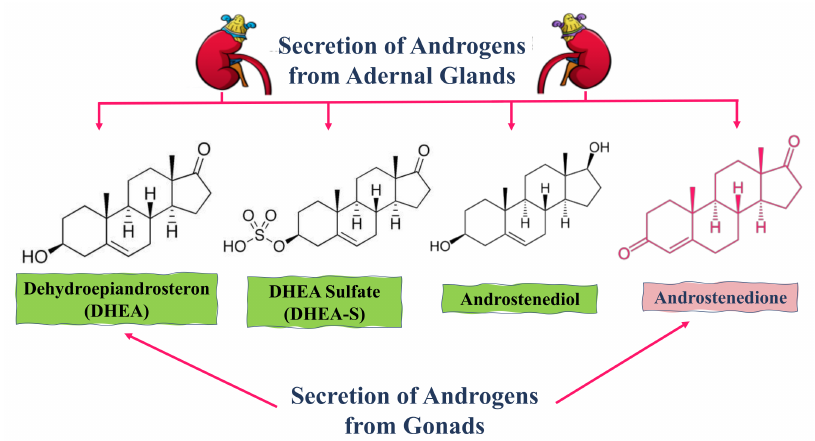
Figure 1. Diagram showing the secretion origins of the main androgenic hormones (steroids) from both adrenal glands and